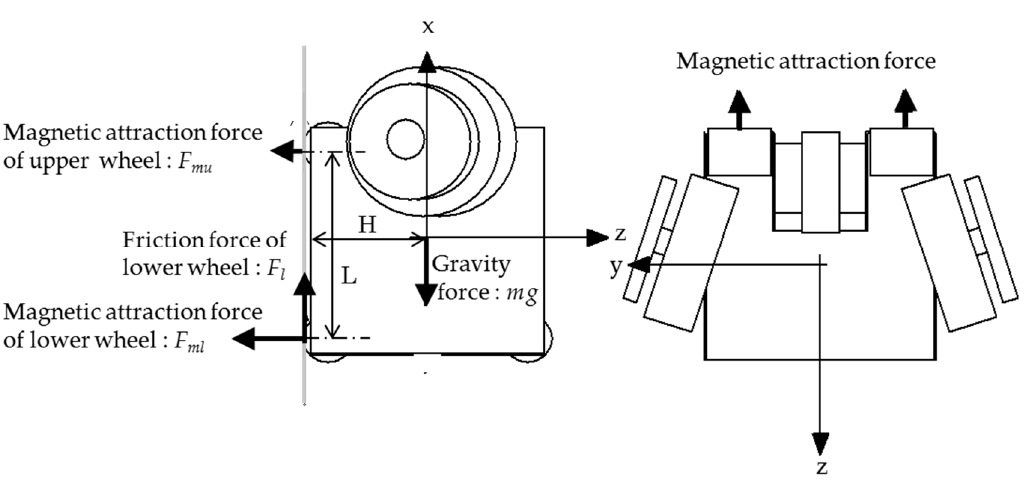
Figure 2. Forces acting on the microrobot when climbing on a wall. F l is the friction force on the lower wheel, F mu and F ml are the magnetic attraction forces of the upper and lower wheels, m g is the gravity force, H is the height of the center of gravity, and L is the wheel distance. The magnetic attraction forces in the upper wheels (driven wheels), F mu , must be actuated to overcome the rotational moment due to its weight in addition to the gripping forces in the lower wheels (driving wheels), F l , to keep the wheels in movement.